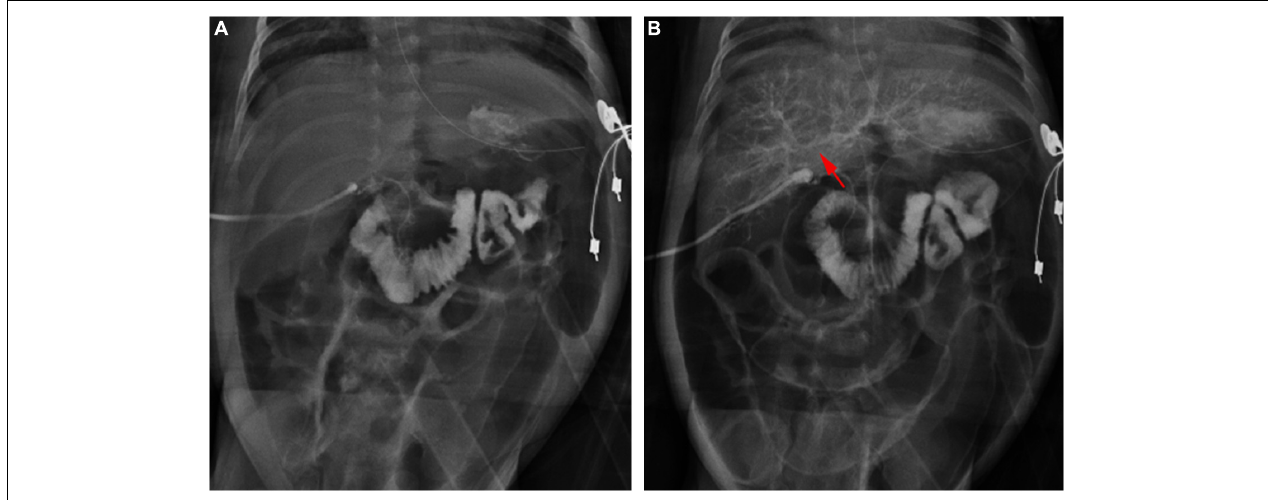
FIGURE 4 | Cholangiography in a 28-day-old patient with TPN cholestasis. (A) Positive cholangiography. (B) Intrahepatic bile ducts (arrow) were shown after repeated biliary irrigation 1 week postoperatively.